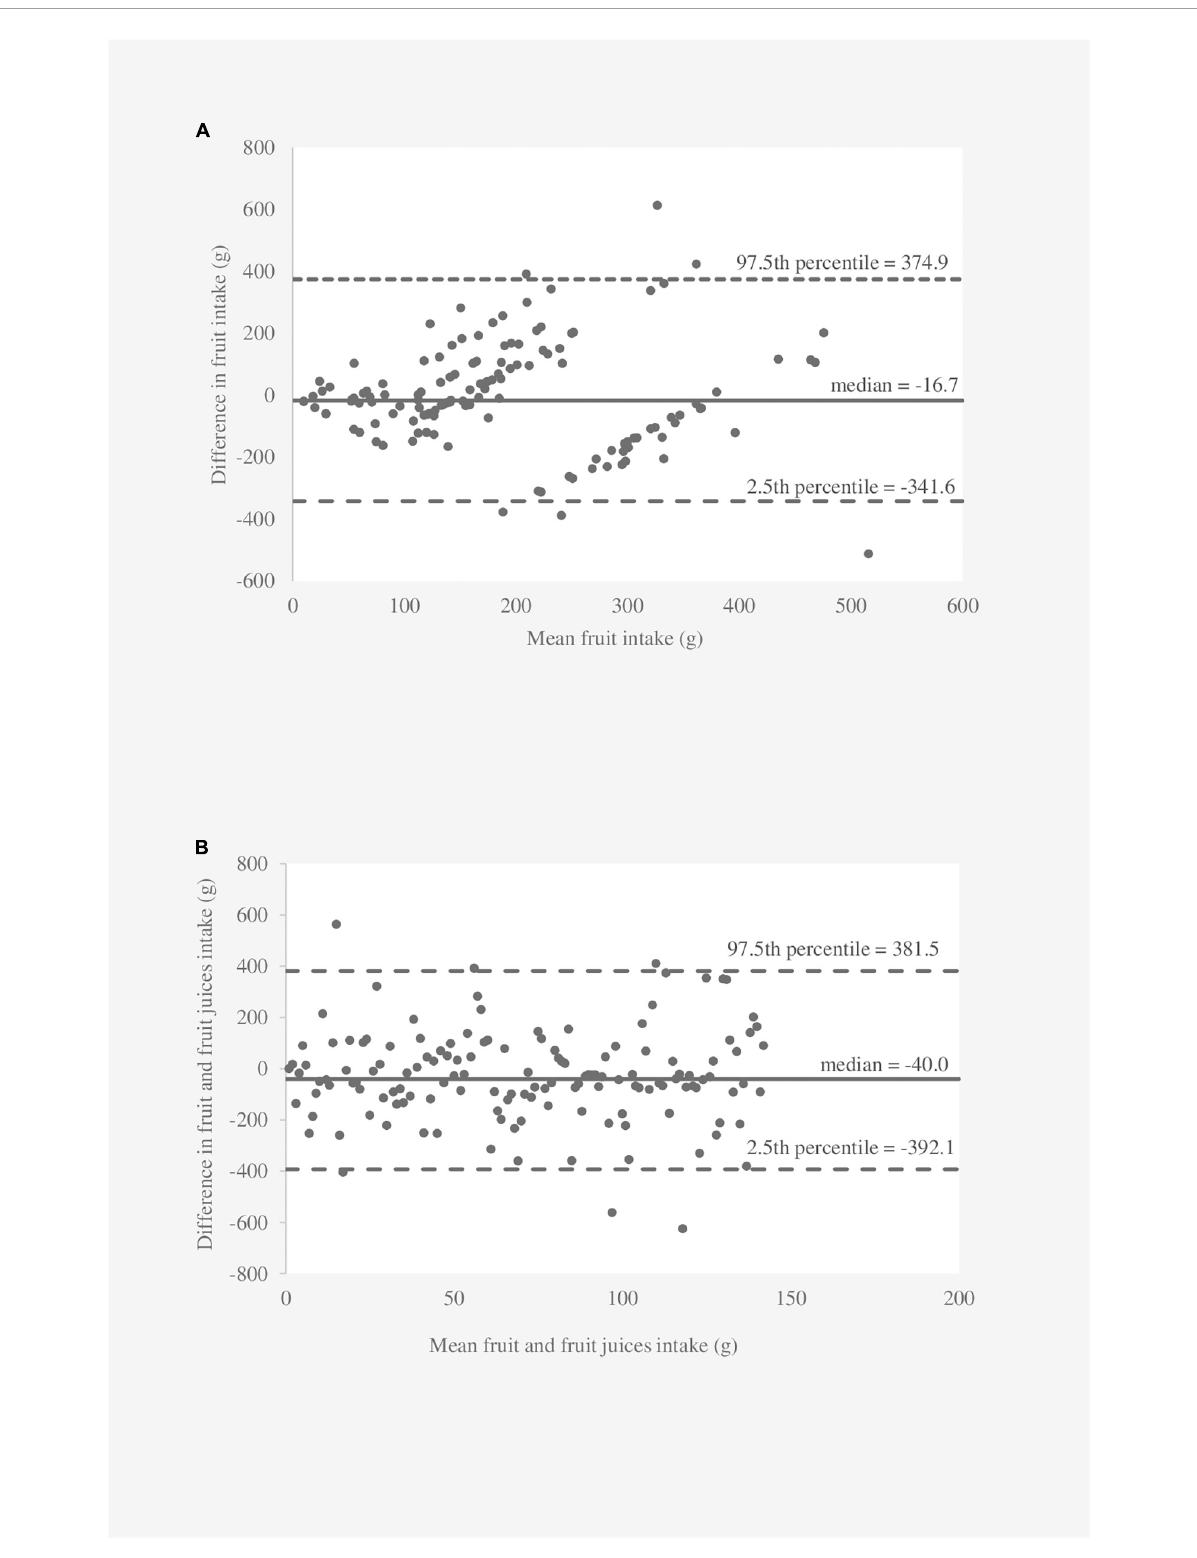
FIGURE1 Bland–Altman plots showing agreement between the 3-day dietary records and the first food frequency questionnaire for consumption of (A) “fruit” and (B) “fruit and fruit juices” per